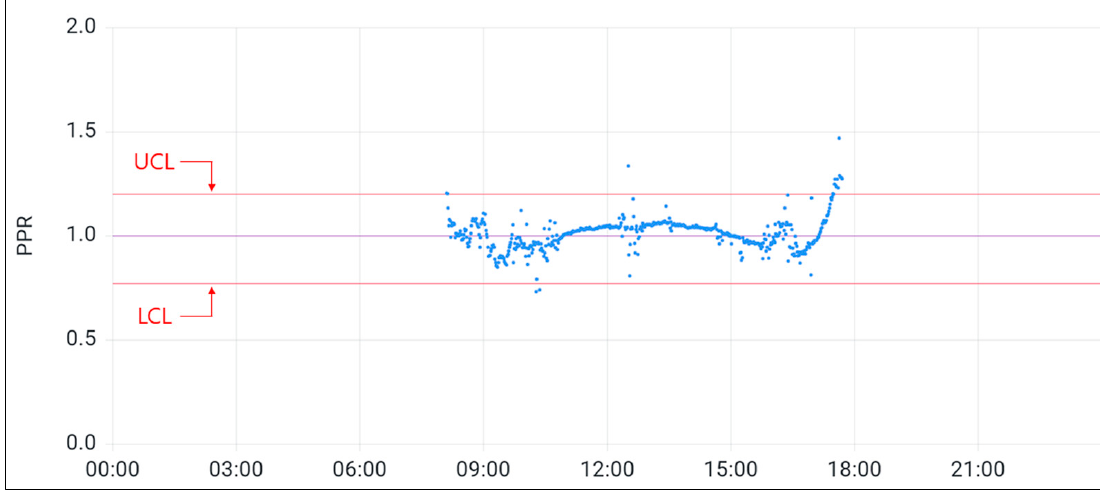
Figure 8. PPR in normal operation.